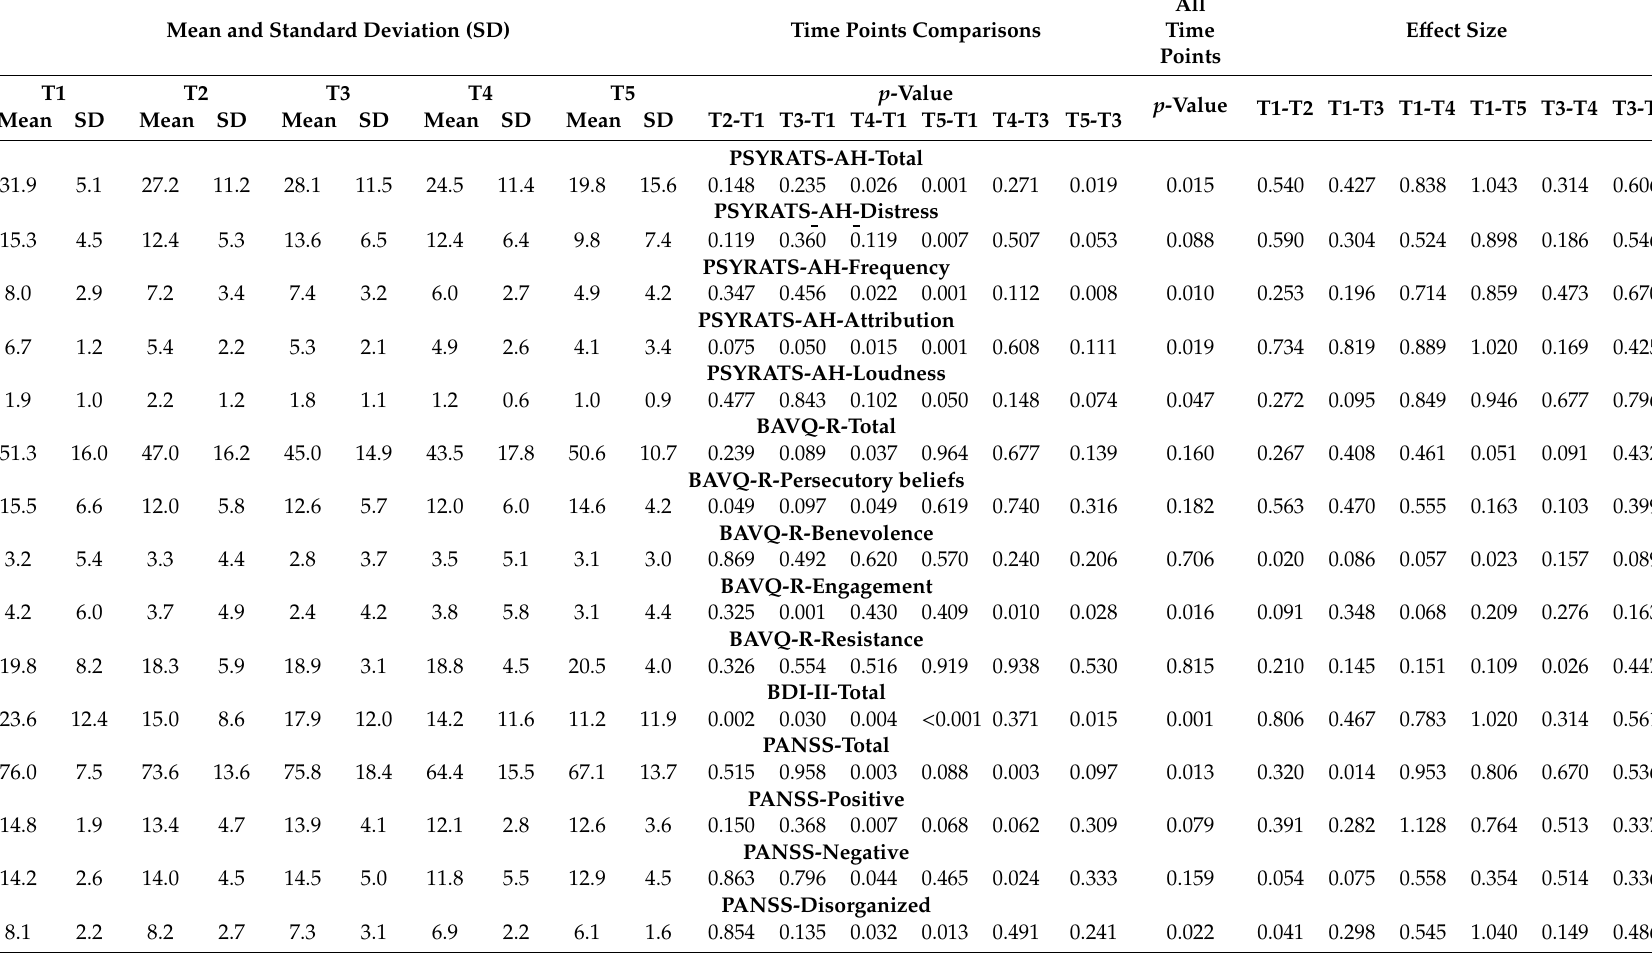
Table 2. Primary and secondary outcomes throughout time points for cognitive behavioral therapy (CBT) + virtual reality-assisted therapy